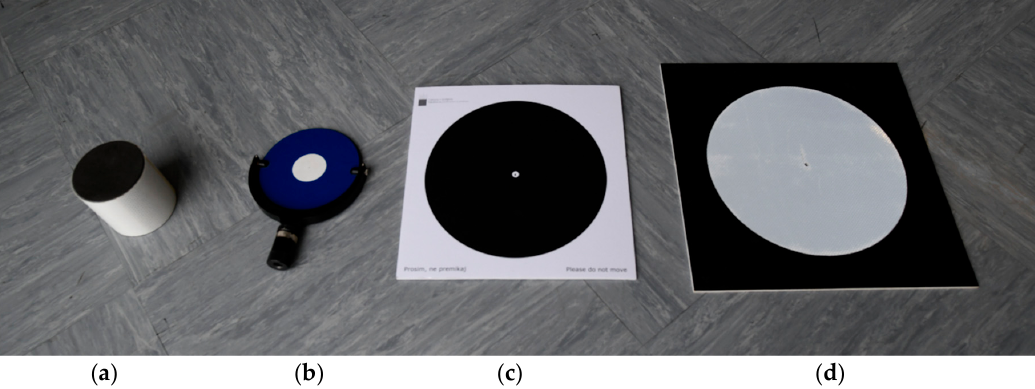
Figure 7. Targets for georeferencing TLS and UAV point clouds: ( a ) Cylindrical retroreflector for the registration of individual scanner stations’ point clouds; ( b ) Tilt & Turn target for georeferencing TLS point clouds; ( c ) photogrammetric ground control point (GCP); ( d ) retroreflective target that was used as a check point.